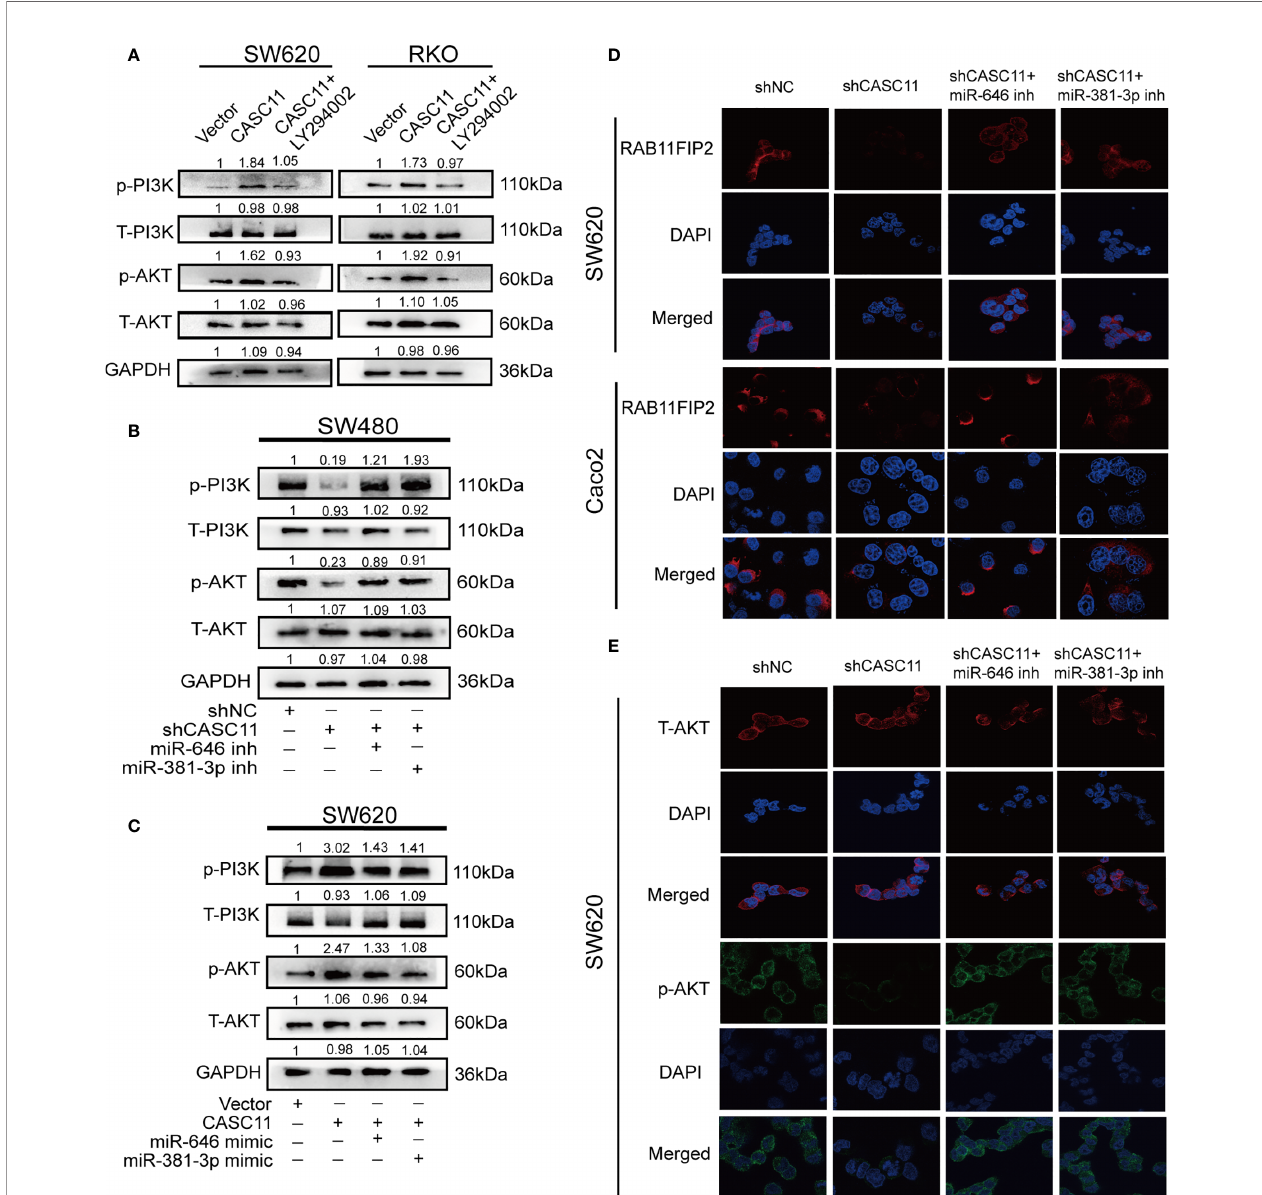
FIGURE 6 | CASC11 is a PI3K/AKT signalling pathway regulator in CRC cells. (A) The levels of the main molecules of the PI3K/AKT pathway in CRC cells transfected with CASC11 overexpression, followed by treatment with LY294002. (B) The main molecules of the PI3K/AKT pathway in CRC cells co-transfected with shCASC11 and the miR-646 or miR-381-3p inhibitor were analyzed. (C) The main molecules of the PI3K/AKT pathway in CRC cells co-transfected with CASC11 overexpression and miR-646 or miR-381-3p mimics were shown. (D, E) IF microscopy of the localization and expression of RAB11FIP2, AKT and p-AKT in CASC11-knockdown cells co-transfected with the miR-646 or miR-381-3p